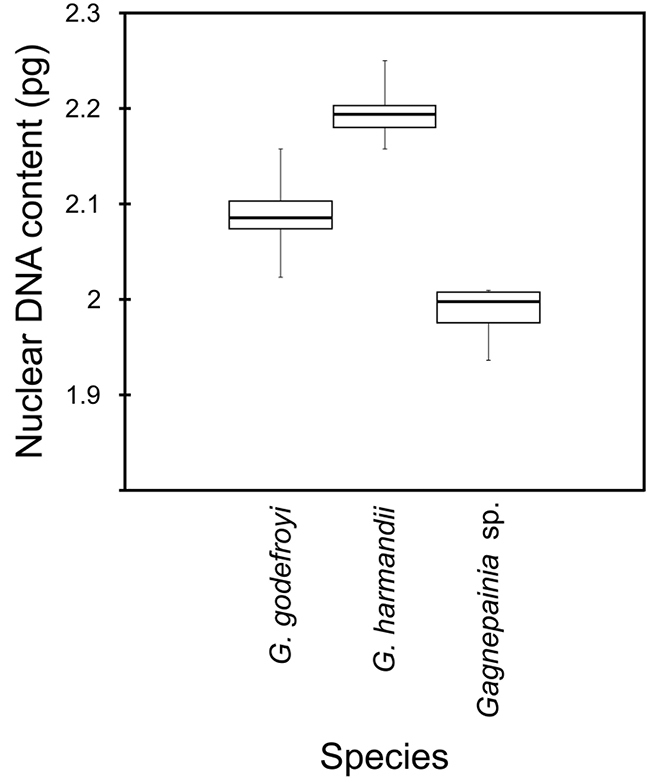
Histograms of the nuclear DNA content of G.
godefroyi and G.
harmandii. Musa
serpentina clone SS&JS 246 was used as the internal reference standard (2C-value = 1.36 pg; Rotchanapreeda et al. 2016).